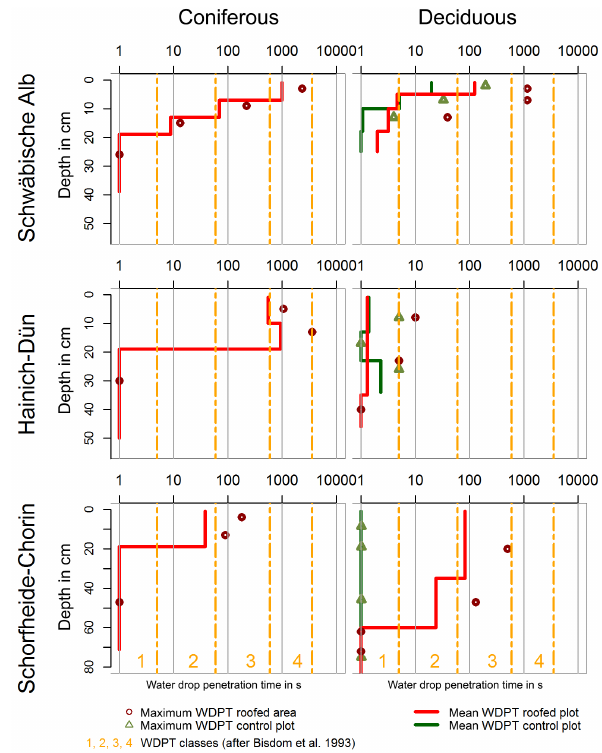
Figure 5. Mean and maximum water drop penetration times (WDPTs) of the control (green) and drought (red) plots. Orange lines and numbers refer to the WDPT classes after Bisdom et al. (1993) (see Table